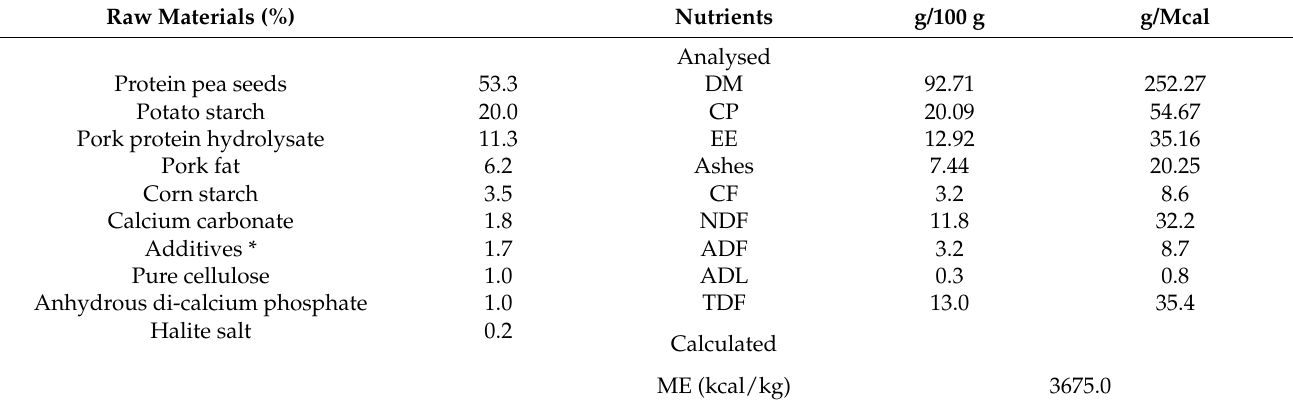
Table 1. Ingredients (% as fed basis) and chemical composition of the extruded dog food used for the dietary trial. Raw Materials